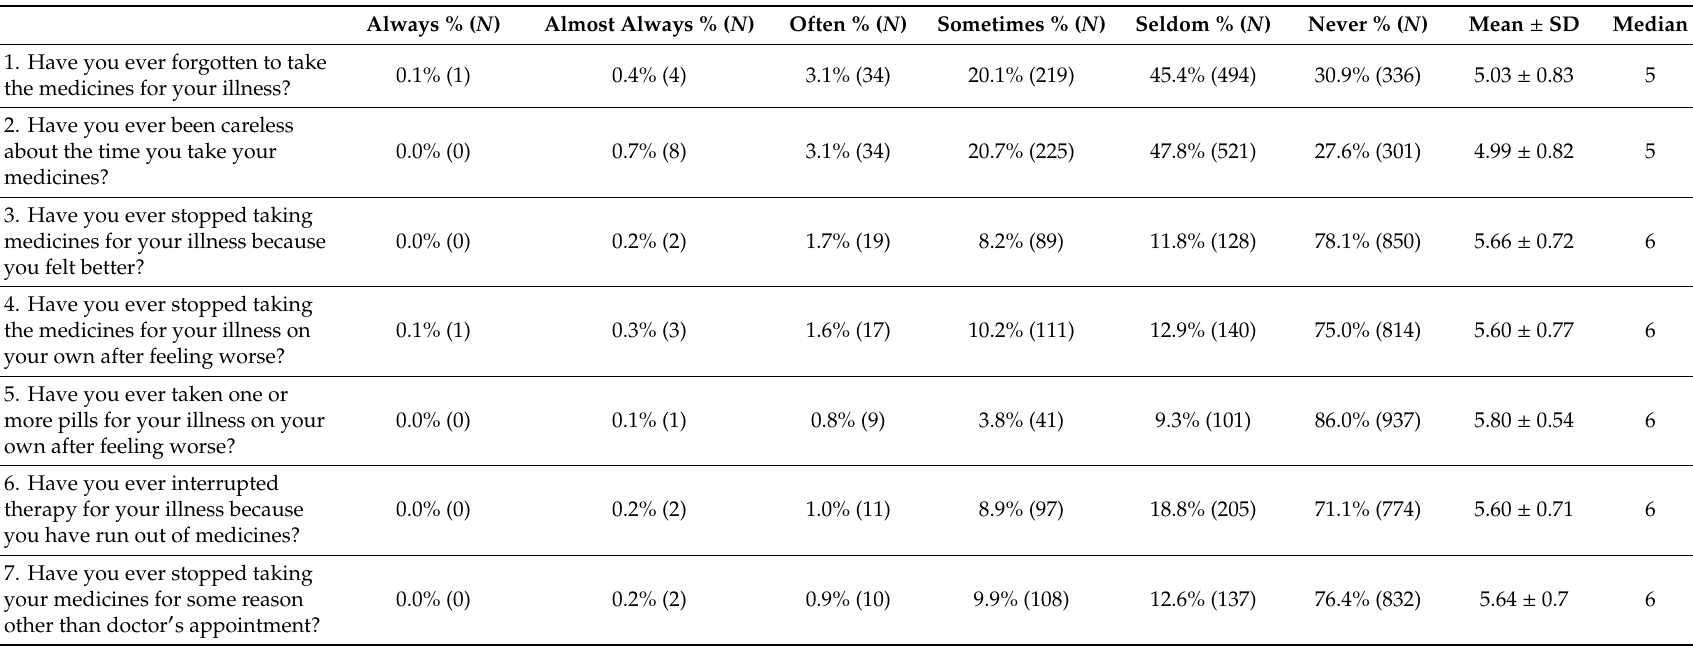
Table 4. Results from the Questions of Adherence Treatment Measure (MAT) and respective Mean and